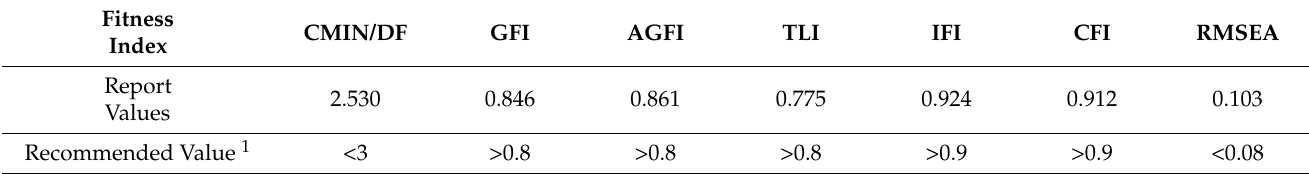
Table 5. Structural equation fitting index.